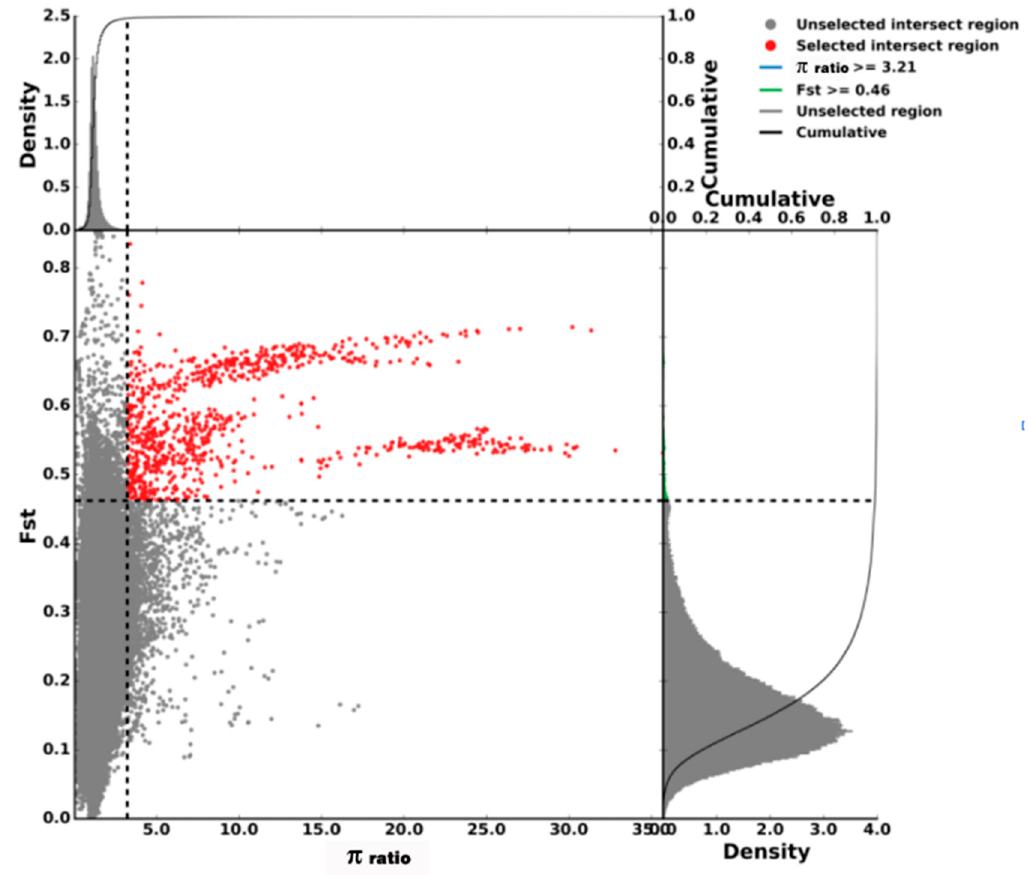
Figure 5. Selective sweeps regions identification of Anqing six-end-white pigs. Note: The final selection regions were based on two statistics. Points located to the right of the vertical dashed lines (corresponding to 1% right tails of the empirical π ratio distribution, where the π ratio was 3.21) and above the horizontal dashed line (1% above tail of the empirical F ST distribution, where Fst was 0.46) were identified as selected regions for Anqing six-end-white pigs (red points).